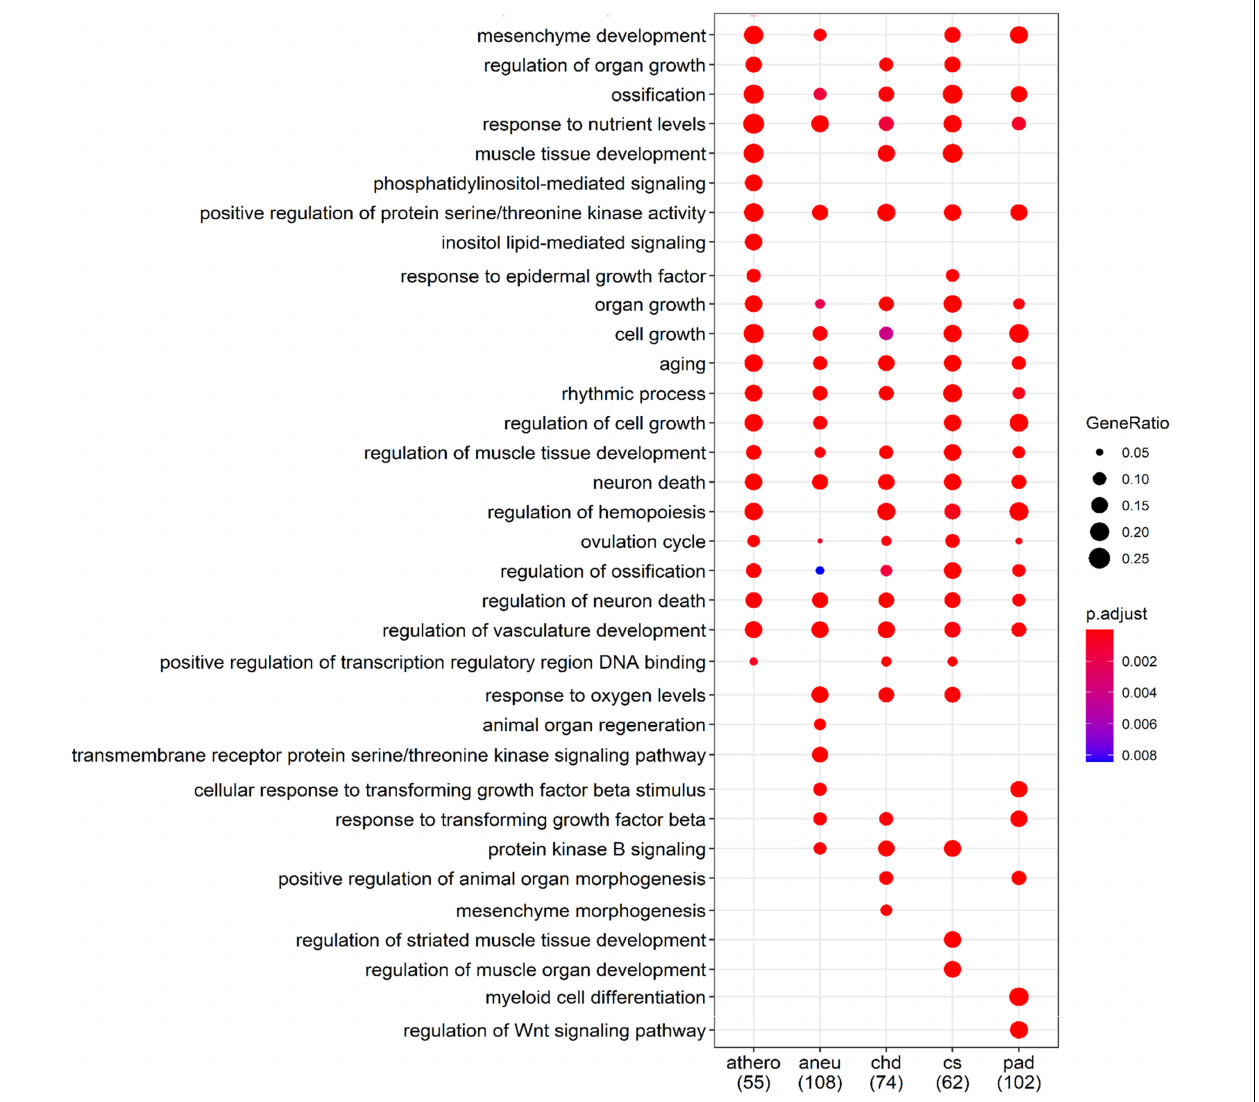
FIGURE 7 | Comparison of the first 34 most enriched GO terms across groups. Gene Ratio indicates the percentage of GO term annotated genes in the gene set. The numbers in brackets indicate the size of the gene set per group; athero = atherosclerosis; aneu = abdominal aneurysm; chd = coronary heart disease; cs = carotid stenosis; pad = peripheral artery